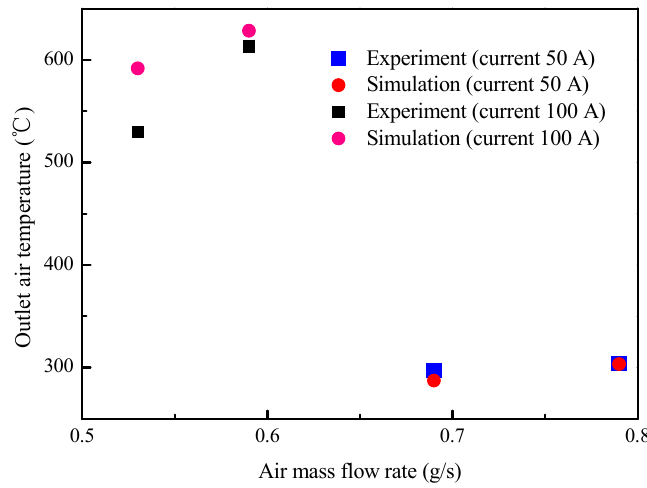
Figure 10. The comparison of time-average quasi-steady outlet air temperatures (height 1.5 m) obtained by experiment and simulation.